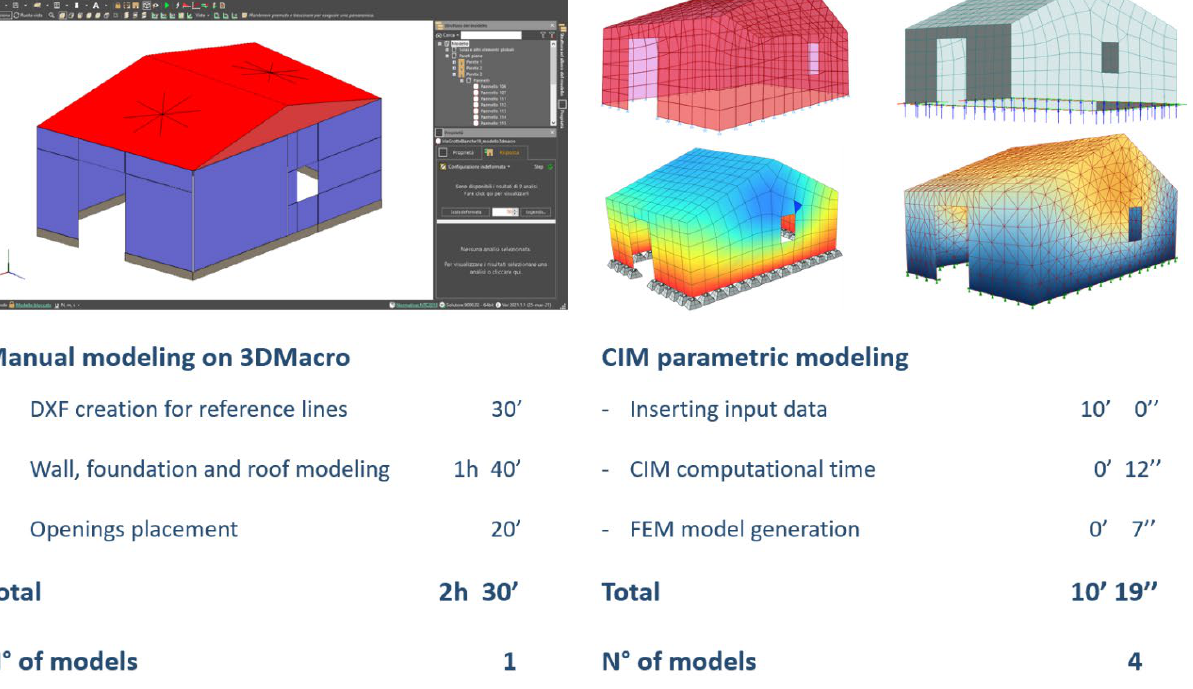
Figure 7 . Comparison of modeling times between a traditional FEM modeling procedure and parametric CIM taking as reference the same geometry but modelled inside a software (well-known and diffused among professionals) for structural analysis of masonry buildings (3DMacro Development Team, 2021). In figure 7 are shown models and times of comparison.